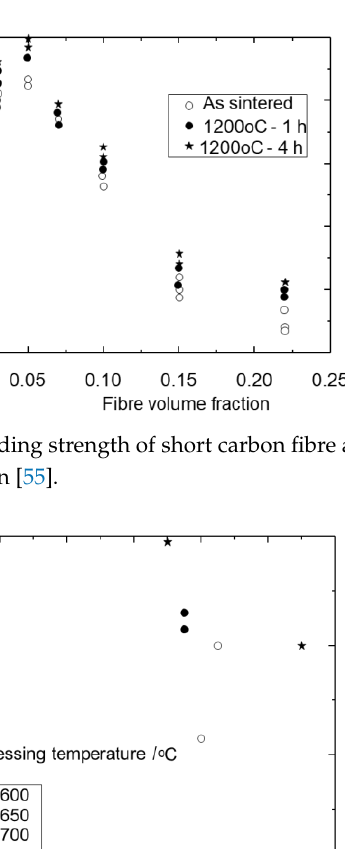
Figure 14. ( a ) Carbide layer thickness in the C/TiC/Ti composites with the initial fibre volume fraction of 20% versus the heat treatment time. The heat treatment temperature is 1075 ◦ C [55]. ( b ) Carbide layer thickness in the composites of the same type with fibre weight fraction of 1% versus the heat treatment time for 240 min. Experimental data published in [56].